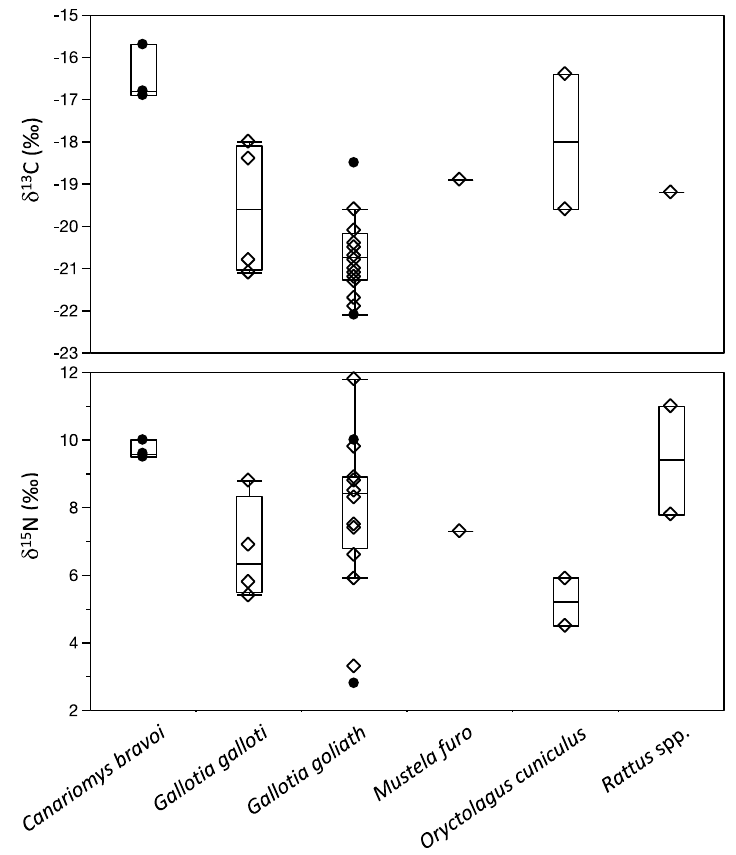
Figure 3. Boxplots comparing δ 13 C and δ 15 N values for taxa at Buenavista del Norte. Boxes represent 25 and 75 ‰ quartiles, and whiskers contain 1.5 times the interquartile range. Diamonds indicate the specimens analyzed in this study.